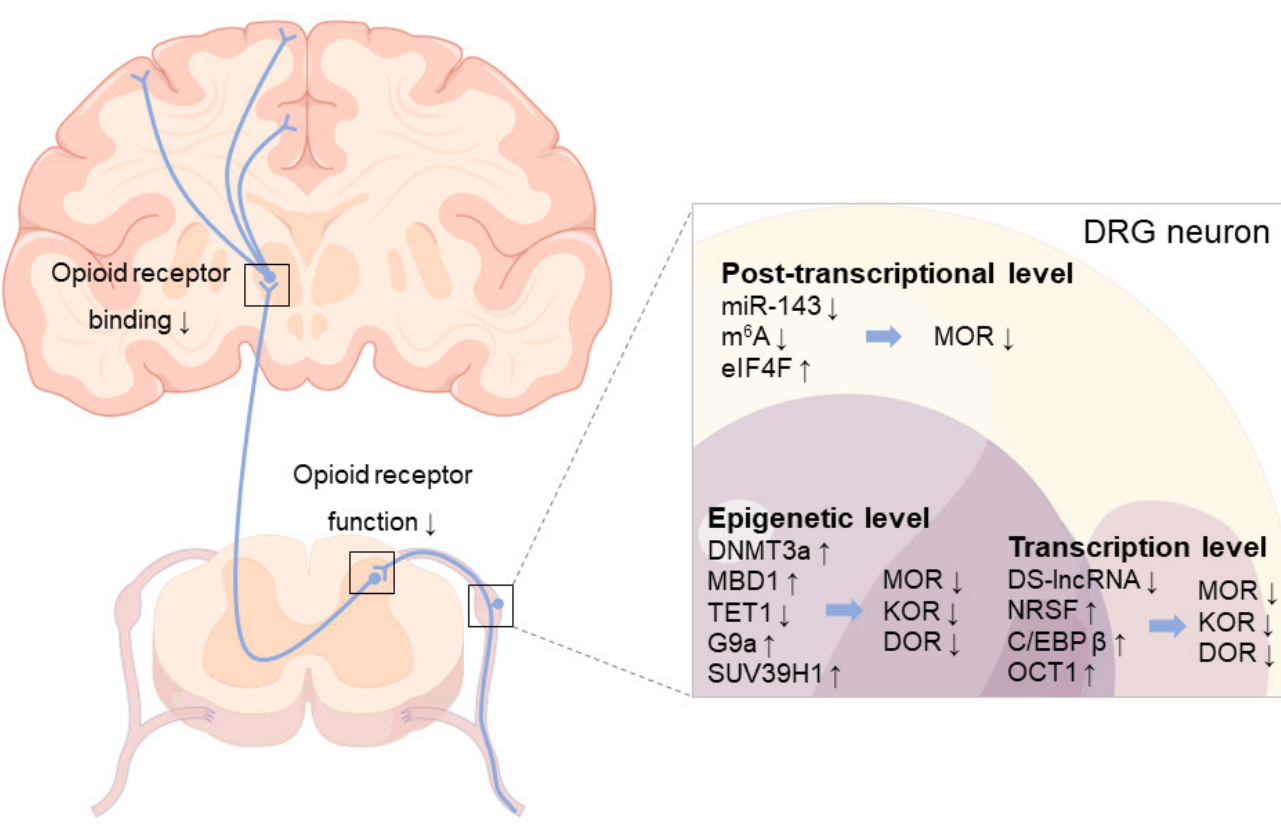
Figure 2. A multidimensional view of opioid receptor downregulation in the NP state. After peripheral nerve injury, opioid receptors in DRG neurons are regulated at epigenetic, transcriptional, and post-transcriptional levels through various mechanisms, leading to the downregulation of opioid receptors and promoting the development of NP. Moreover, the decrease in opioid receptor binding in some brain regions (e.g., posterior midbrain; anterior cingulate; medial thalamus; and the insular, temporal, prefrontal cortices, inferior parietal cortices, etc.) and the downregulation of opioid receptors in the spinal dorsal horn cord can be observed following NP. Arrows indicate changes in gene or receptor expression, as well as decreased opioid receptor function and binding.